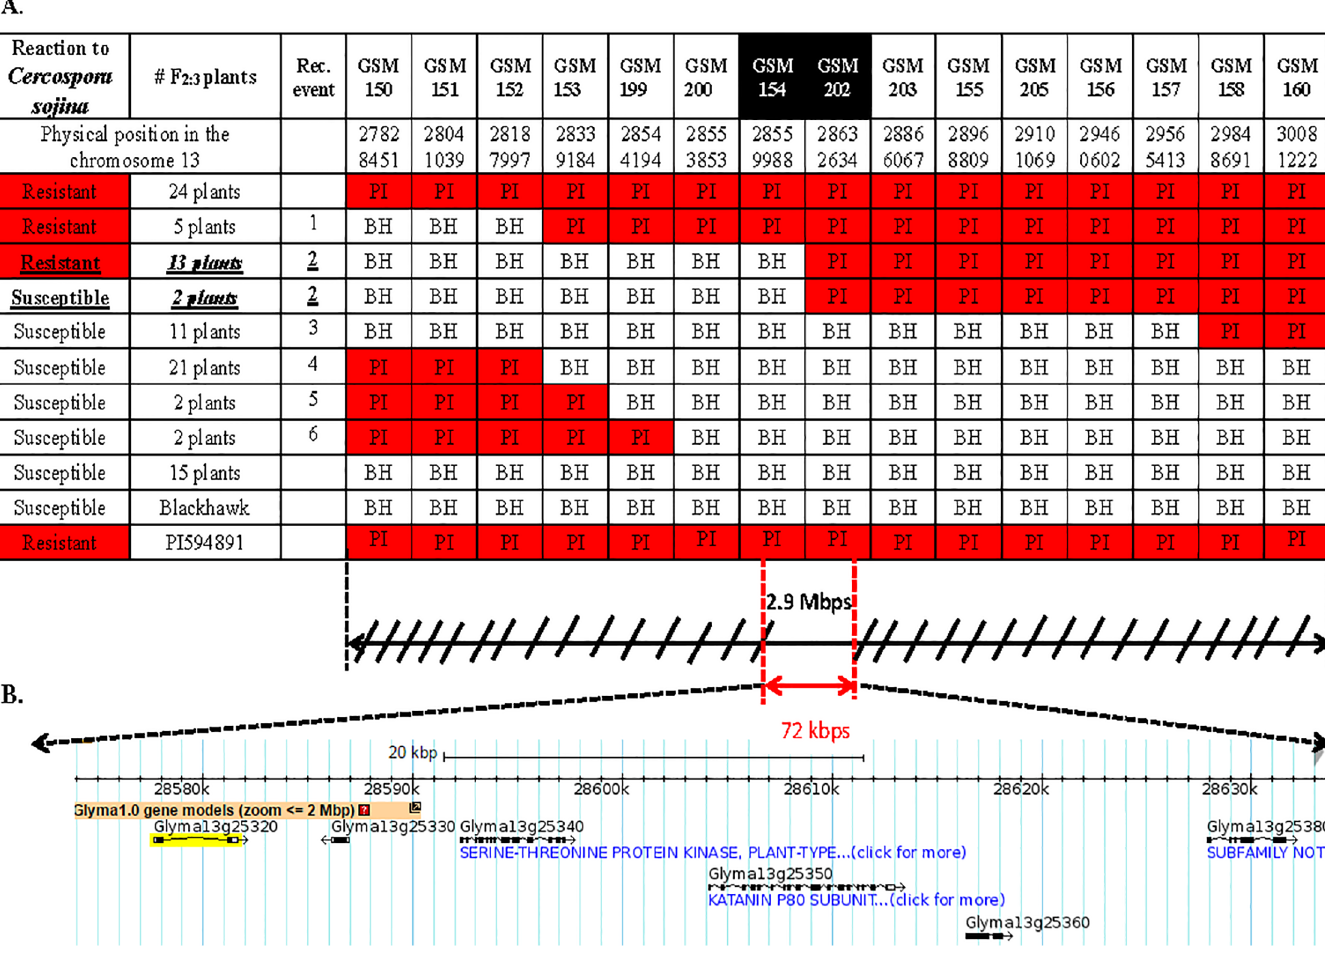
Fig 1. SNP genotypes at 15 SNP loci and the reaction of F 2:3 plants with recombination events to Cercospora sojina (race 8) in a Blackhawk x PI 594891 population. A. Genotypes at 15 SNP marker loci and the reactions of F 2:3 plants with recombination events to Cercospora sojina in the population of Blackhawk x PI 594891. The 15 plants that were highlighted and underlined had the same recombination breakpoint (No. 2), but opposite phenotypes (BH = Blackhawk allele; PI = PI 594891 allele; Het = heterozygous alleles). B . Screen shot of Williams 82 genome (assembly version 1.01) (http://SoyBase. org), displaying a 72.6 kb region on chromosome 13 which contained the locus responsible for the resistance in PI 594891.